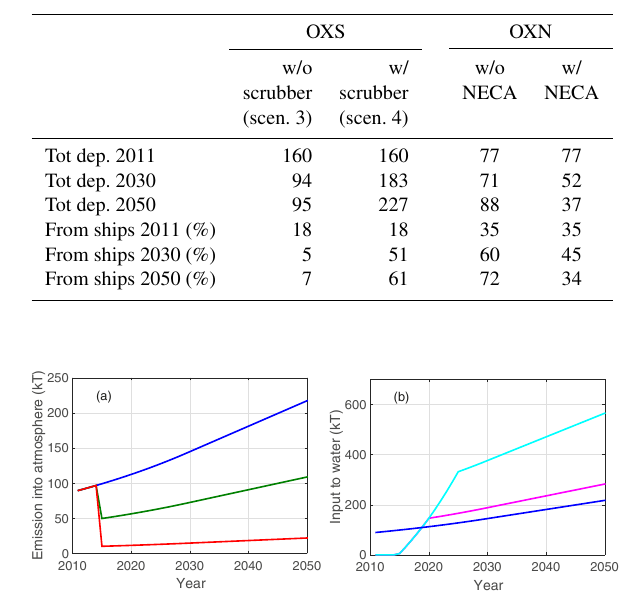
Table 3. Total deposition of OXS and OXN in the Baltic Sea (Ggyr − 1 ).